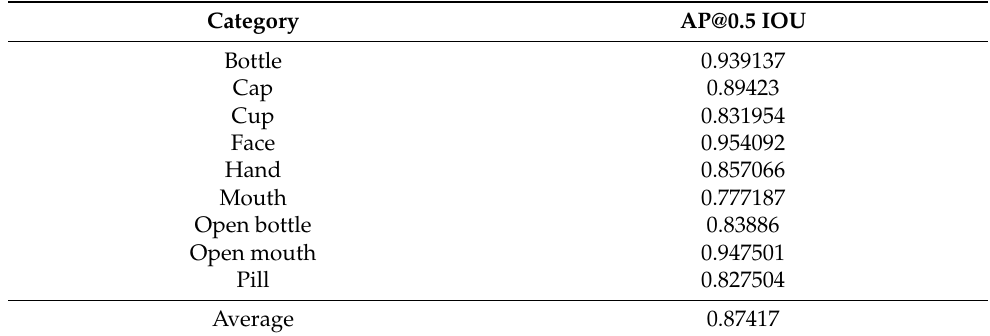
Table 1. Results of AP@0.5 on object examples.